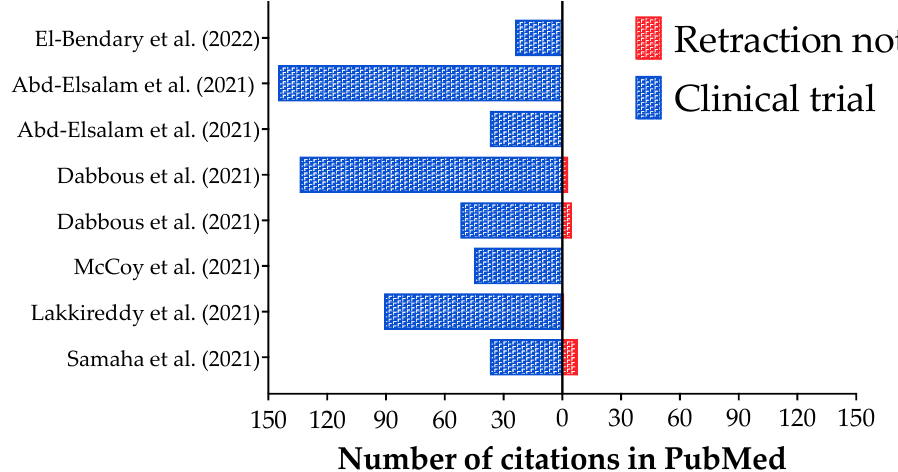
Figure 1. Number of citations in Pubmed database for the retracted clinical trials about Coronavirus Disease (COVID)-19 interventions and their retractions notes. References: [9-16].